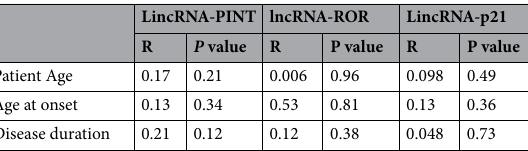
Table 5. Correlation analysis between expression levels of lncRNAs and clinical data.